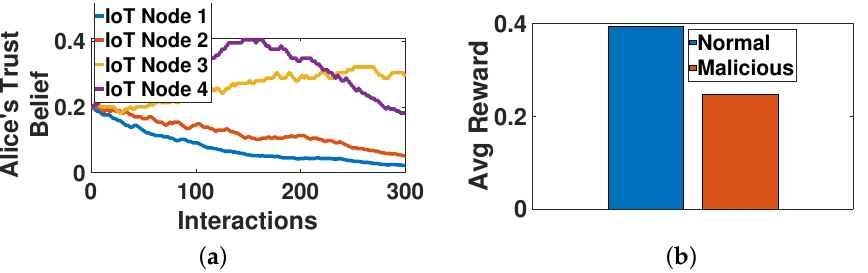
Figure 5. Behavioral change evaluation. ( a ) Alice’s belief vs. interactions, ( b ) average reward vs. behaviors.